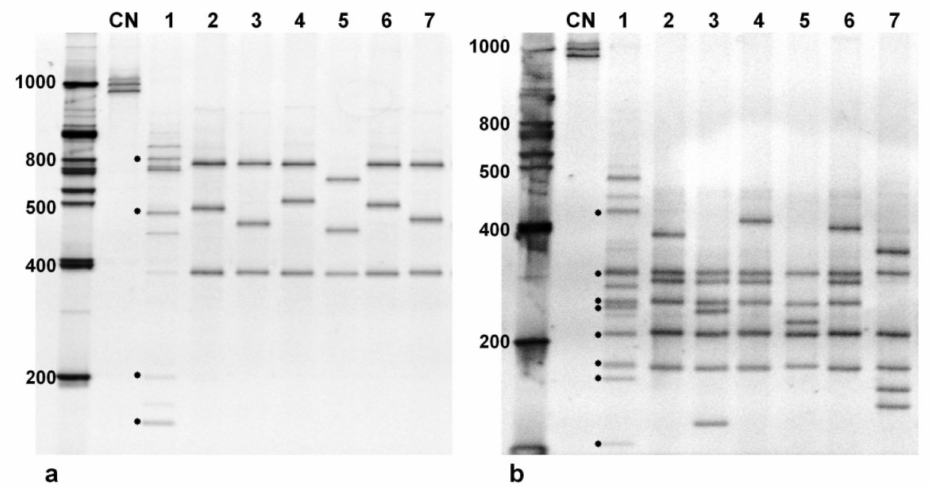
Figure 3. DNA digestion of PCR products from A m y alleles of the materials evaluated using Dde I ( a ) Figure 2. DNA digestion of PCR products from A m x alleles of the materials evaluated using Hae III and Pst I ( b ) endonucleases. The band size of the molecular weight marker is expressed in bp. Lanes endonuclease. The band size of the molecular weight marker is expressed in bp. Lanes are as fol ‐ are as follows: 1 , common wheat cv. Cheyenne; 2 , PI 427498; 3 , PI 427497; 4 , PI 427622; 5 , PI 554504; 6 , lows: 1 , common wheat cv. Cheyenne; 2, PI 427498; 3, PI 427497; 4, PI 427622; 5, PI 554504; 6, PI PI 470720; and 7 , PI 427575. CN , cv. Cheyenne without digestion. The digestion of the Ay subunit 470720; and 7, PI 427575. CN , cv. Cheyenne without digestion. The digestion of the Ax2* subunit from cv. Cheyenne (  ) was used as from cv. Cheyenne (